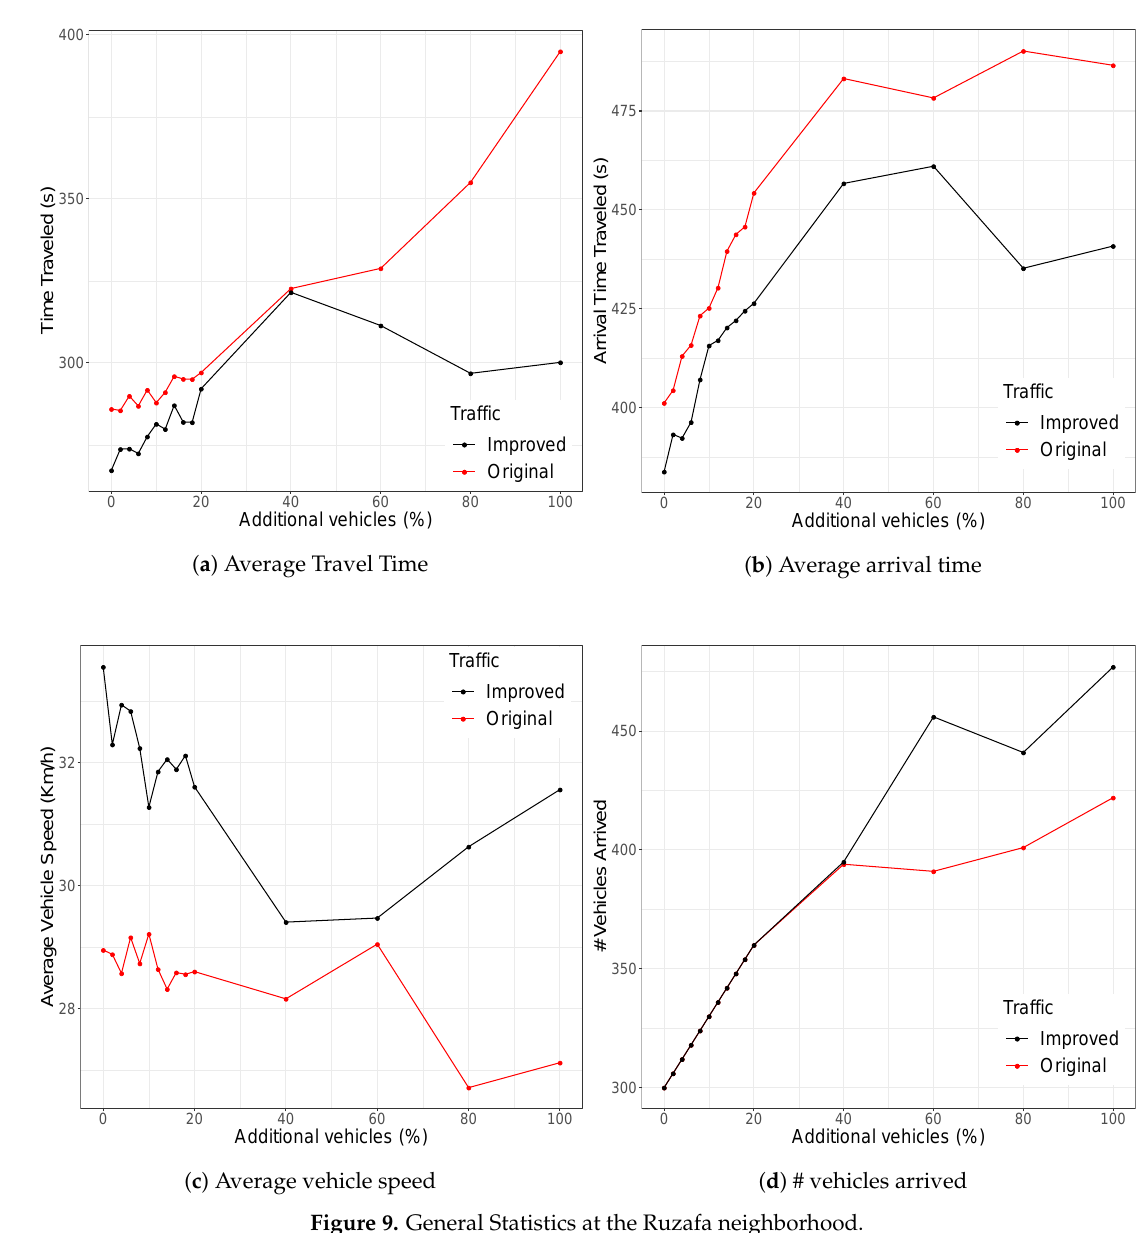
Figure 9. General Statistics at the Ruzafa